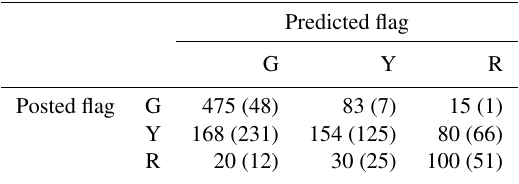
Table 3. Number of days and rescues (in brackets) based on the combination of posted and predicted flag